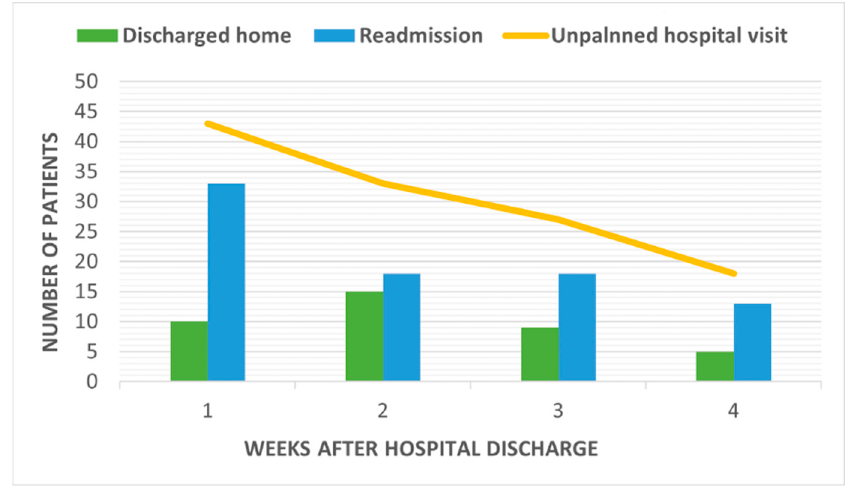
Figure 1. Number of unplanned hospital visits by patients following pancreaticoduodenectomy by